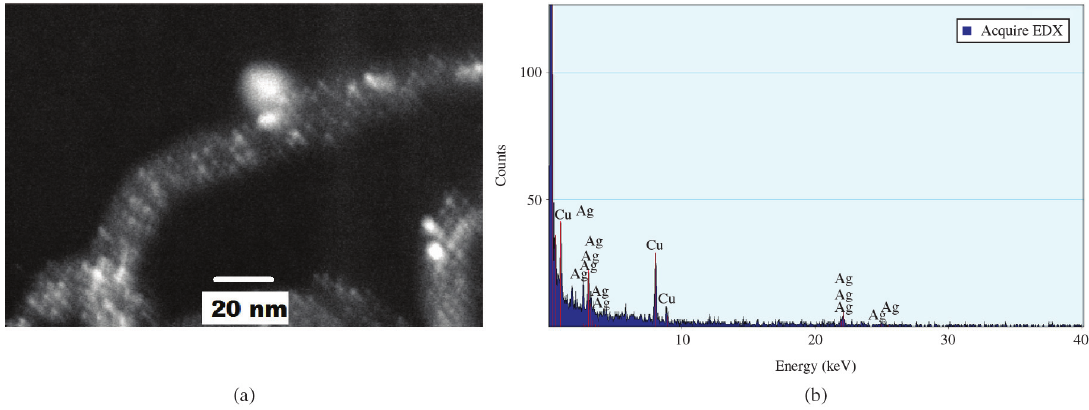
Figure 4. A- Detail of Ag decorated MWCNT-F surface in HAADF STEM mode. Ag nano-particles, having higher atomic number than carbon, diffracts electrons at higher angles. B- EDS spectrum collected from one of the bright particle in